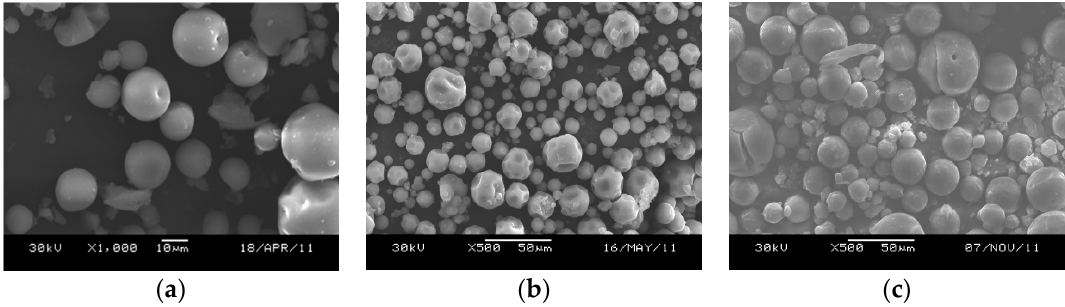
Figure 3. Morphology of the catalyst with different TiCl 4 -contacting temperatures. ( a ) − 25 ◦ C; ( b ) 0 ◦ C; ( c ) 25 ◦ C.